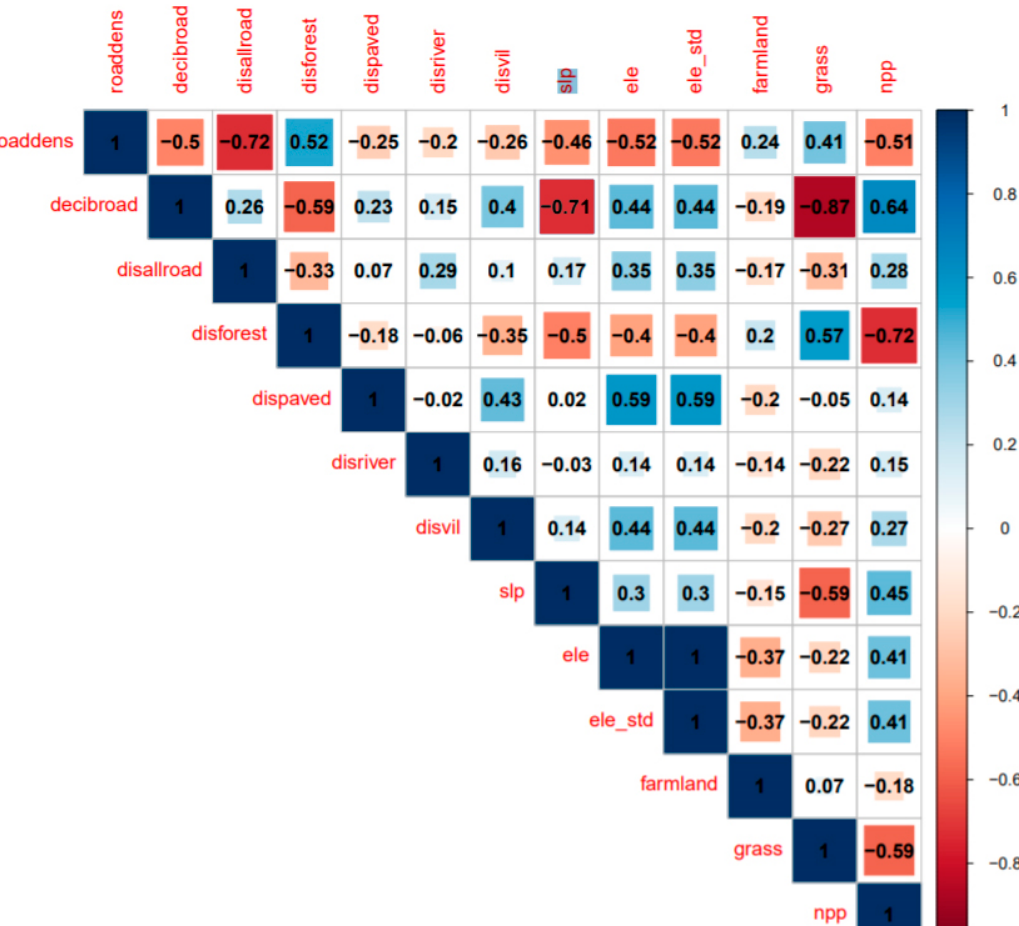
Table 2. Level II single variable optimized scale for habitat selection.